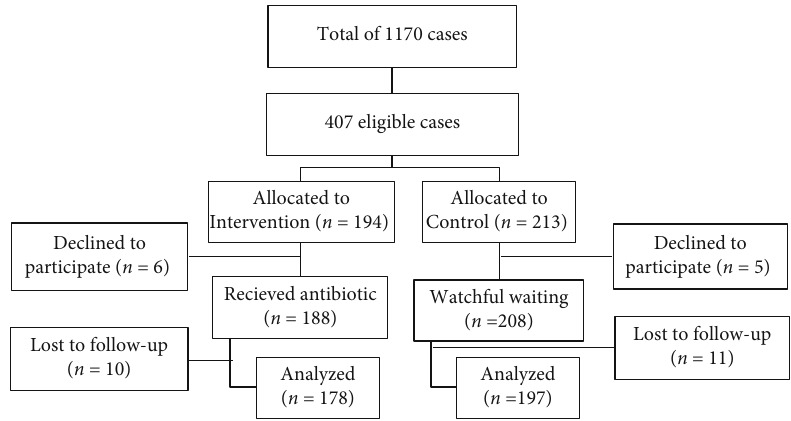
Figure 1: Flow chart of the study allocation and follow-up. Table 1: Demographic and characteristics of the